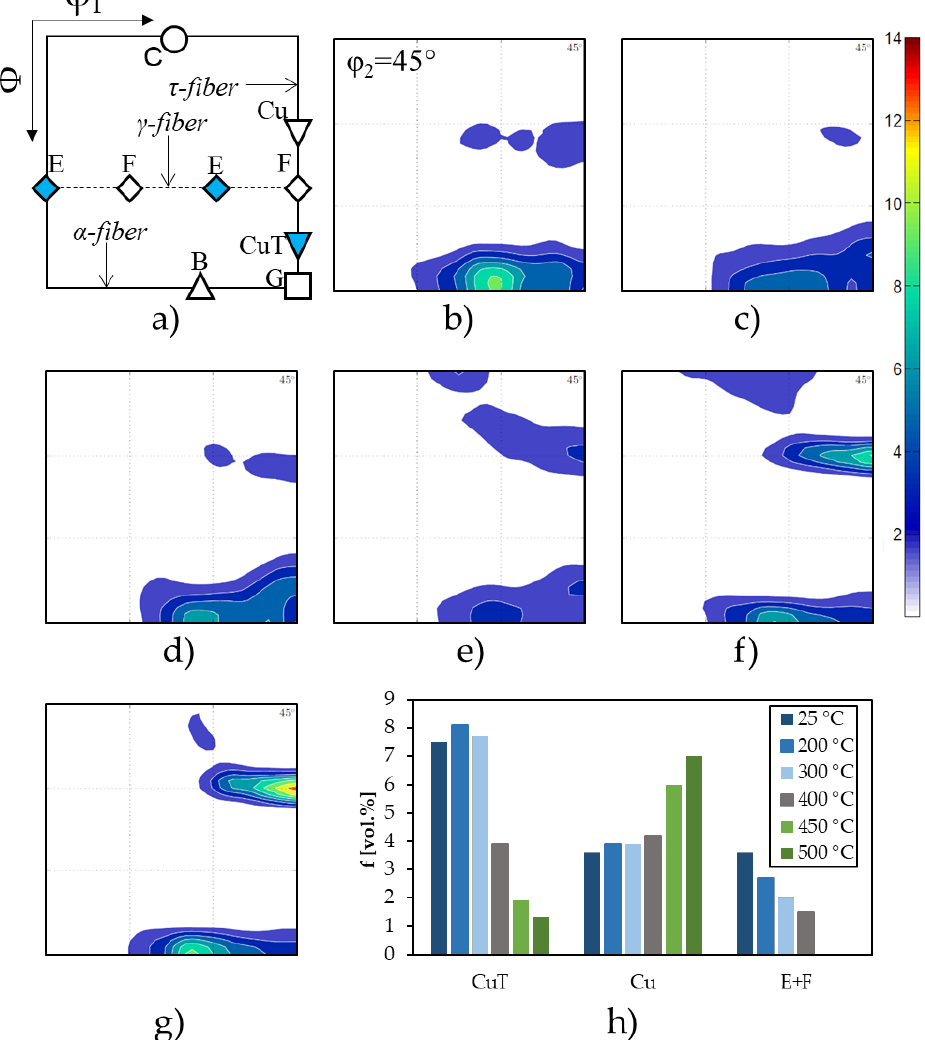
Figure 4. Texture formation of the material rolled to 50% thickness reduction at different temperatures. ( a ) Schematic presentation of the ideal texture component in the orientation distribution functions (ODF) section at φ 2 = 45°. ODF sections at φ 2 = 45° for ( b ) 25 °C, ( c ) 200 °C, ( d ) 300 °C, ( e ) 400 °C, ( f ) 450 °C, ( g ) 500 °C, and ( h ) presentation of the volume fractions of selected texture components.